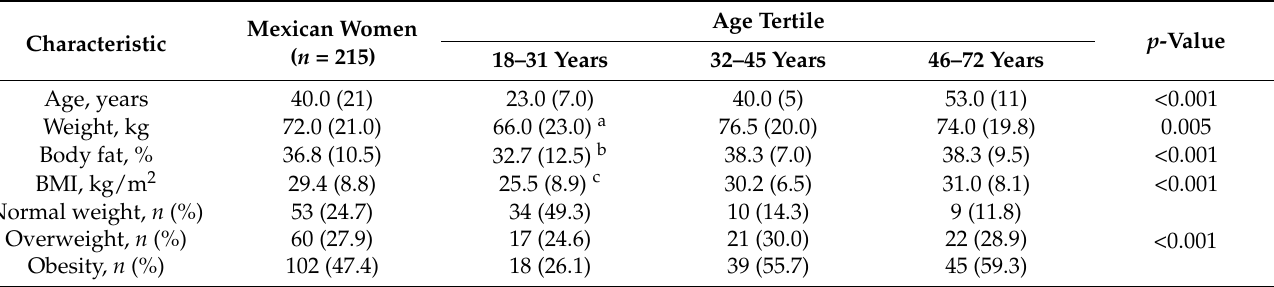
Table 2. Characteristics of Mexican